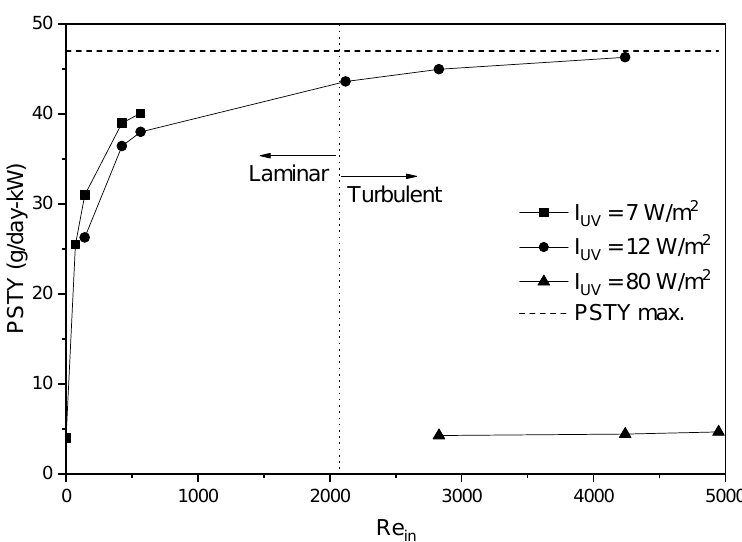
Figure 14. Photocatalytic Space-time Yield